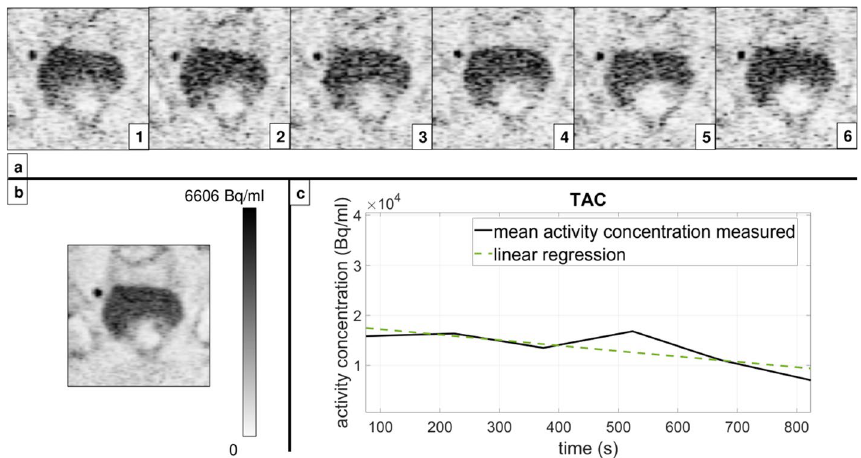
Fig. 2 18 F-PSMA-1007 PET images (patient 51) of the prostate scanning range reconstructed in dynamic mode ( a ) and static mode ( b ) with the corresponding TAC ( c